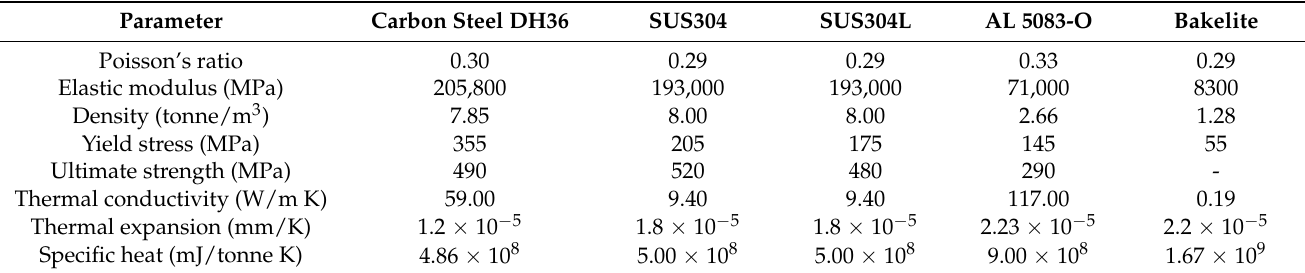
Table 2. Mechanical and thermal properties of target